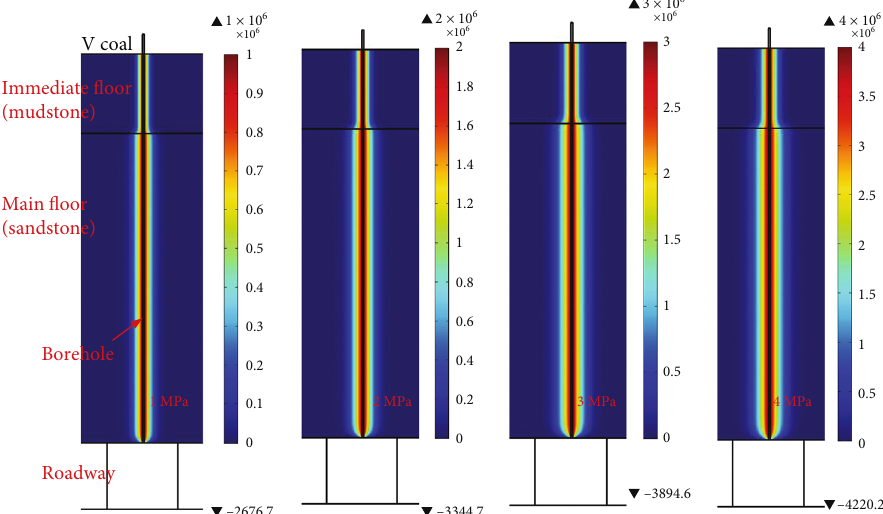
Figure 10: Seepage distribution of the inorganic slurry in borehole under di ff erent grouting pressures.